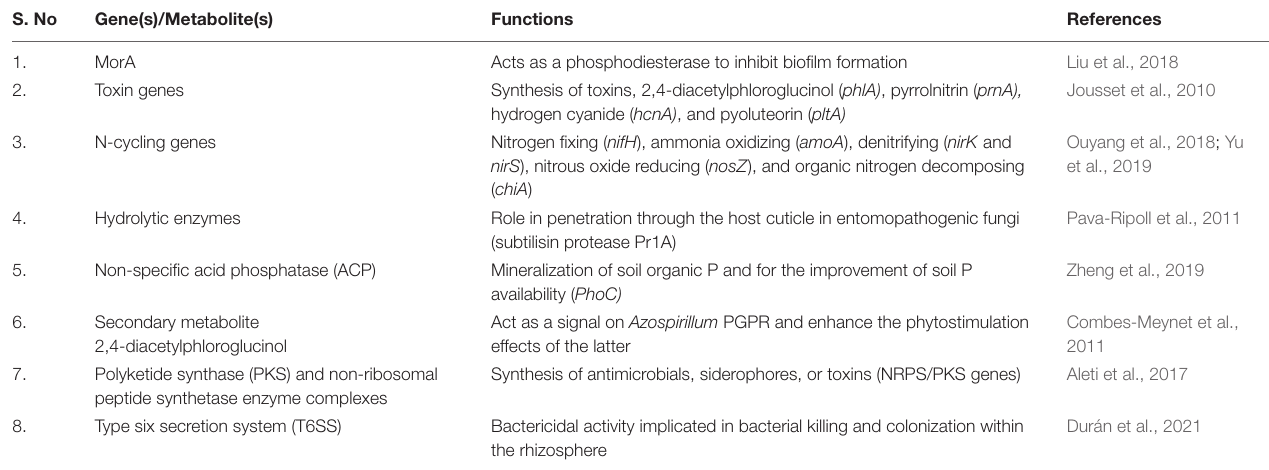
TABLE 1 | Metagenome genes and their functions involved in plant